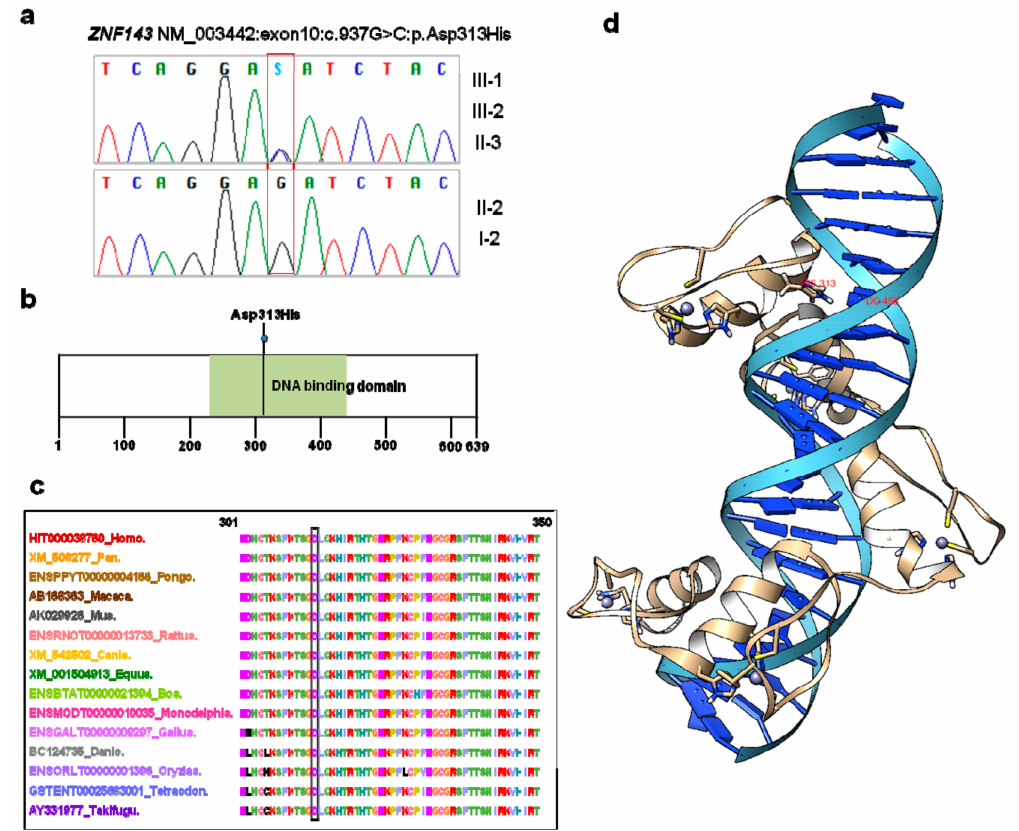
Figure 2. ZNF143 mutation leading polymorphous corneal dystrophy maps to conserved domains and amino acid residues. ( a ) Sanger sequencing of the ZNF143 gene from RNA. ( b ) ZNF143 is a 639-amino-acid protein containing a DNA-binding domain. ( c ) The ZNF143 positions a ff ected by missense alterations (box) show amino acid conservation between species among vertebrates. ( d ) The complex structure of ZNF143 p.Asp313His and DNA is shown in a cartoon representation generated by using UCSF Chimera. A mutation residue from Asp to His is shown with the label HIS313. Zinc ions in grey are shown with two Histidine and two Cytosine